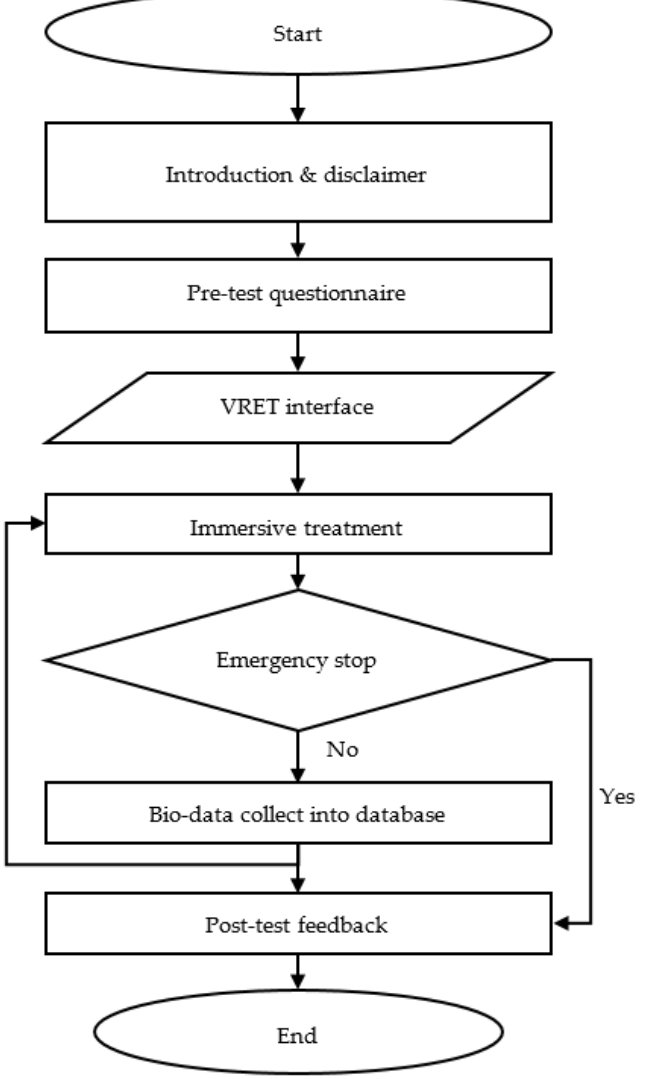
Figure 3. The driving phobia VRET experiment flow.